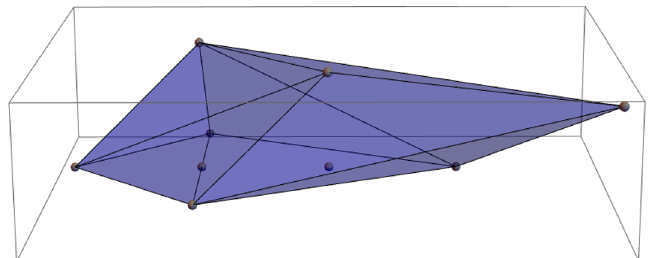
Figure 21 . A 3 d projection of the toric diagram for the moduli space, corresponding to (6.13). The projection corresponds to the following combination of rows: ( G